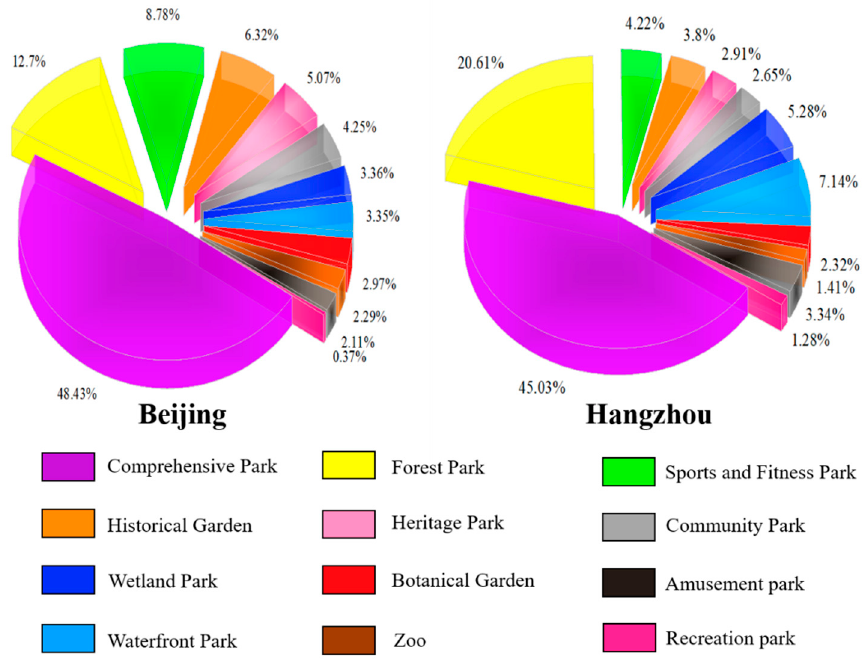
Figure 17. Proportion distribution of 12 types of urban parks in Beijing and Hangzhou.